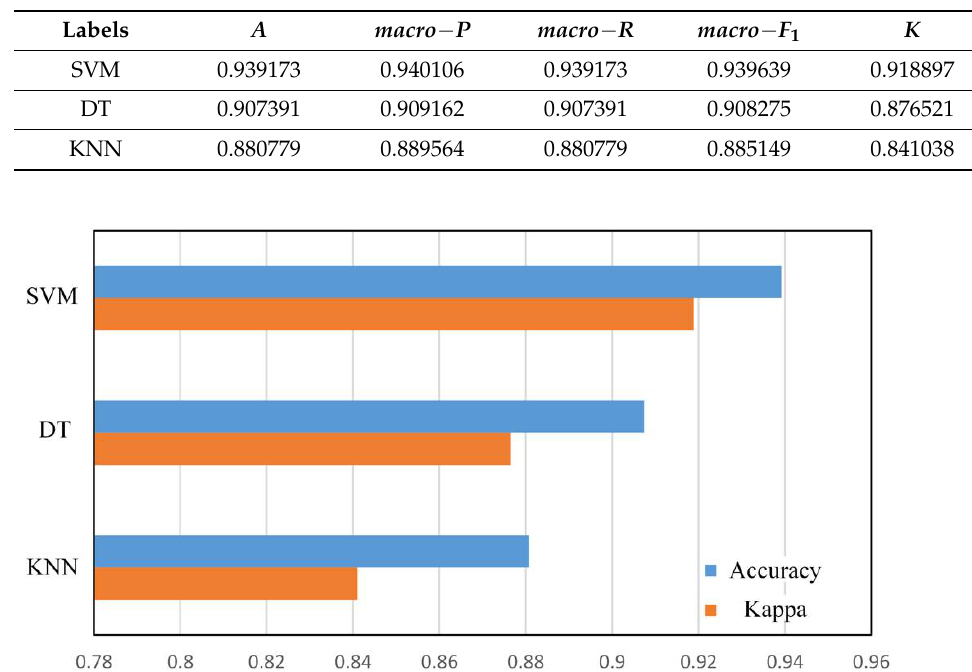
Figure 7. Comparison of model accuracy and Kappa coefficient of different algorithms.